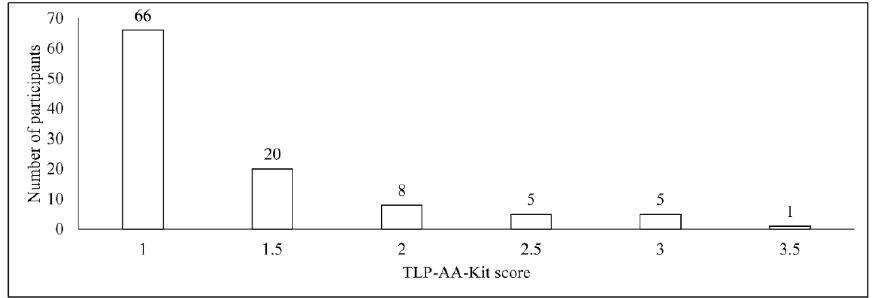
Figure 1. Frequency table of participants according to the Trypsin-Like Peptidase Activity Assay Kit (TLP-AA-Kit) score.